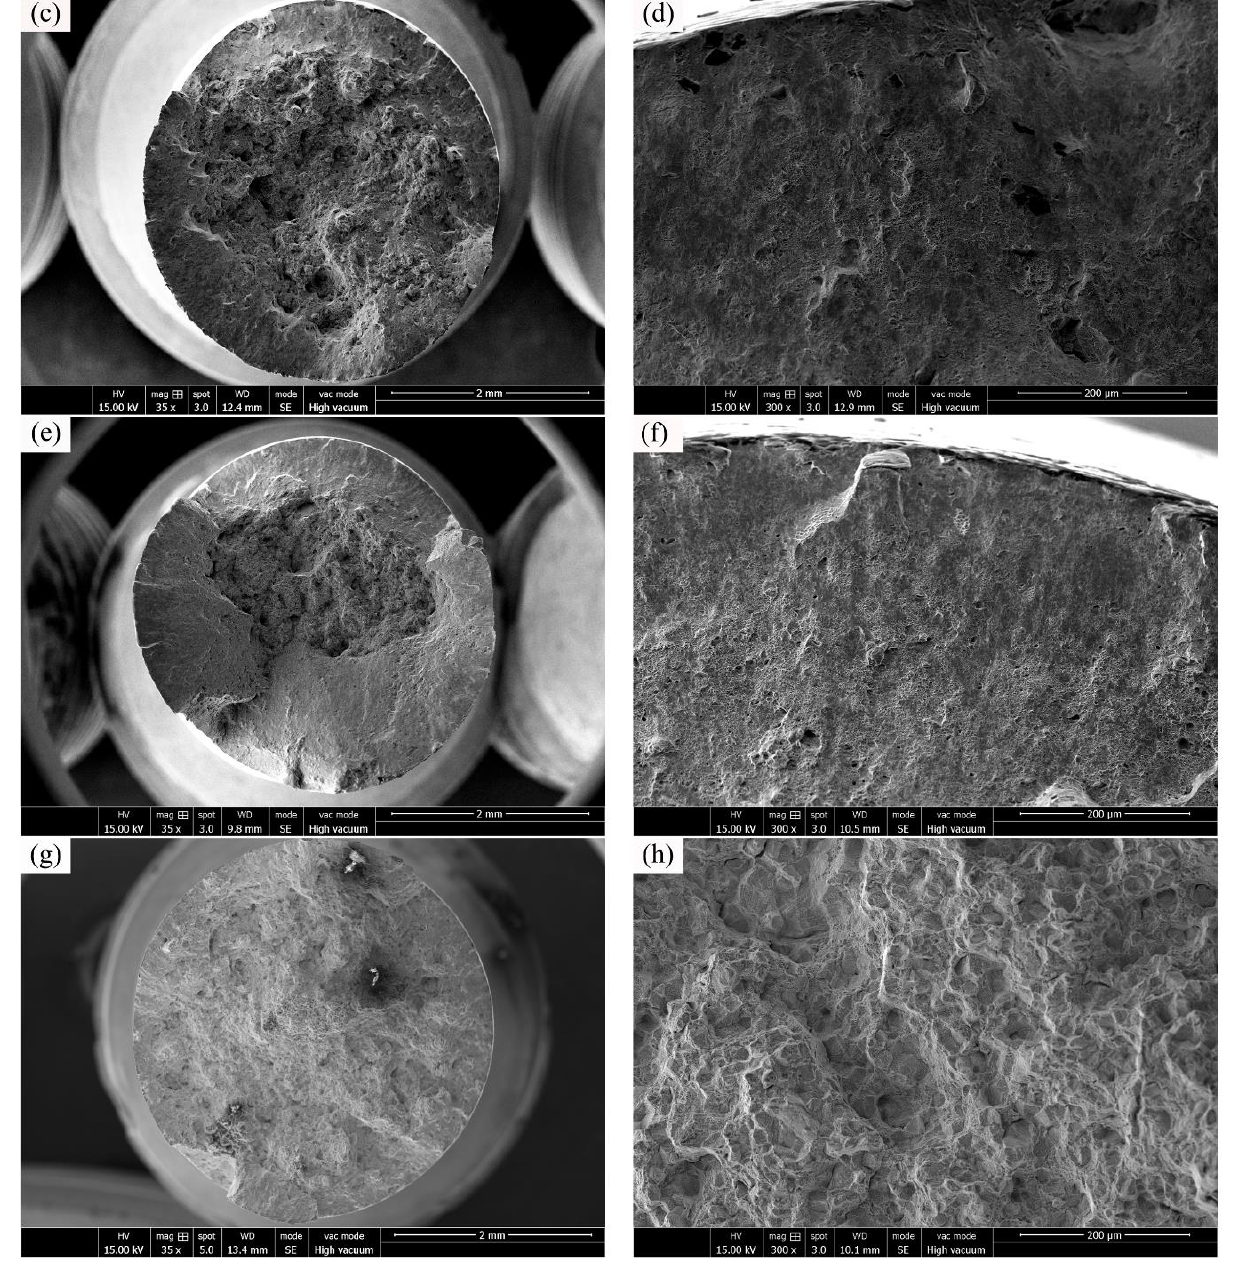
Figure 9. Tensile fractured surfaces of C17200 beryllium copper alloy tested at different temperatures. ( a ) General view of tensile fracture surface at 25 °C; ( b ) central fracture area morphology at 25 °C; ( c ) general view of tensile fracture surface at 150 °C; ( d ) topography of sliding zone at 150 °C; ( e ) general view of tensile fracture surface at 350 °C; ( f ) topography of sliding zone at 350 °C; ( g ) general view of tensile fracture surface at 450 °C; and ( h ) central fracture area morphology at 450 °C.